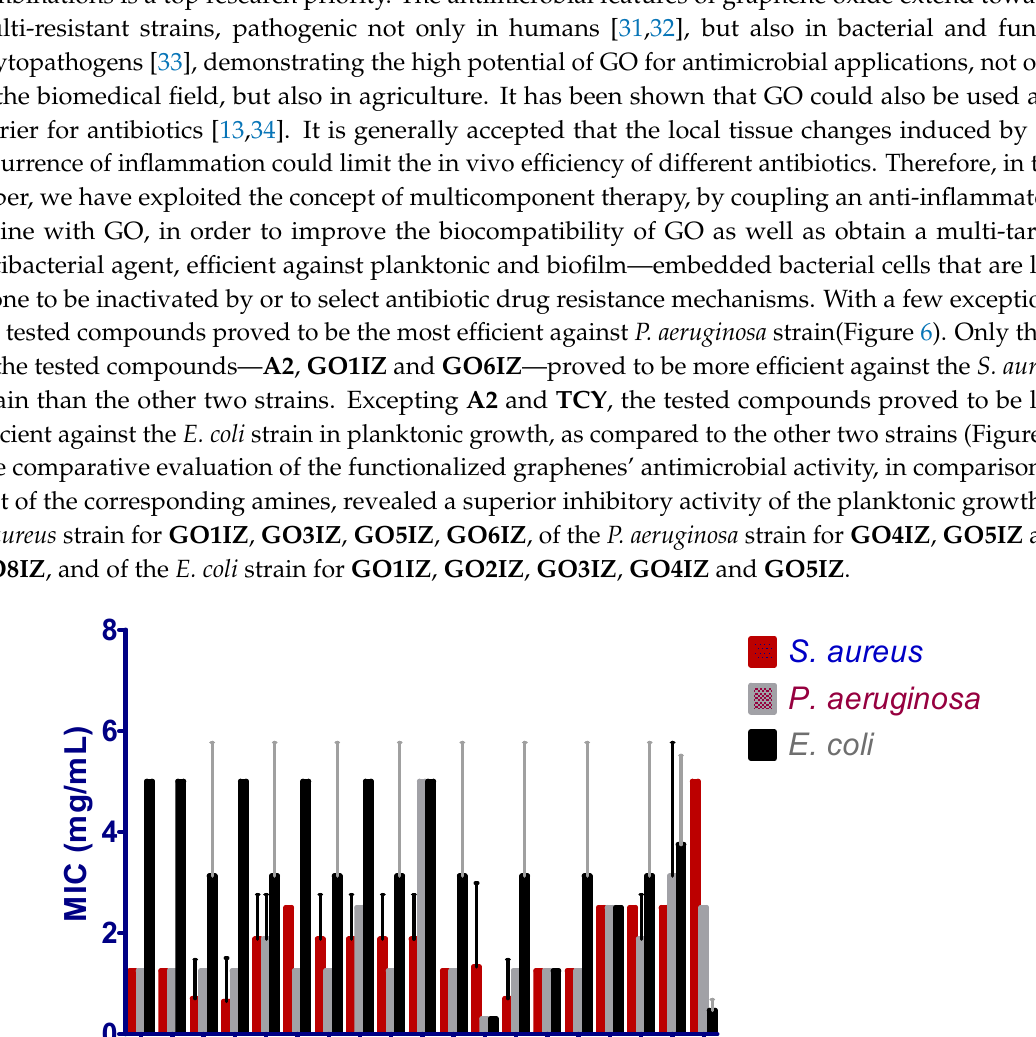
Figure 5. SEM pictures of samples GO1IZ – GO8IZ .